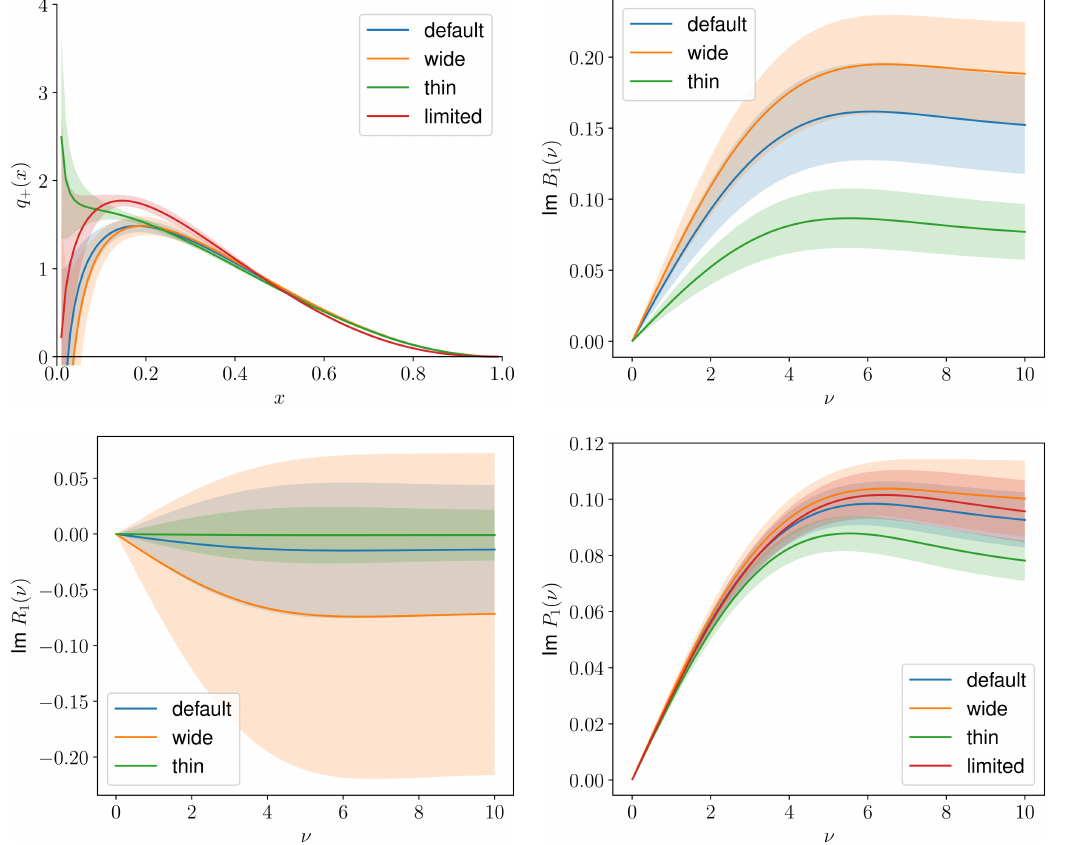
Figure 11 . The results of fitting to the models of Tab 3. The PDF is given by the upper left, B 1 ( ν ) is given by the upper right, R 1 ( ν ) is given by the lower left, and P 1 ( ν ) is given by the lower